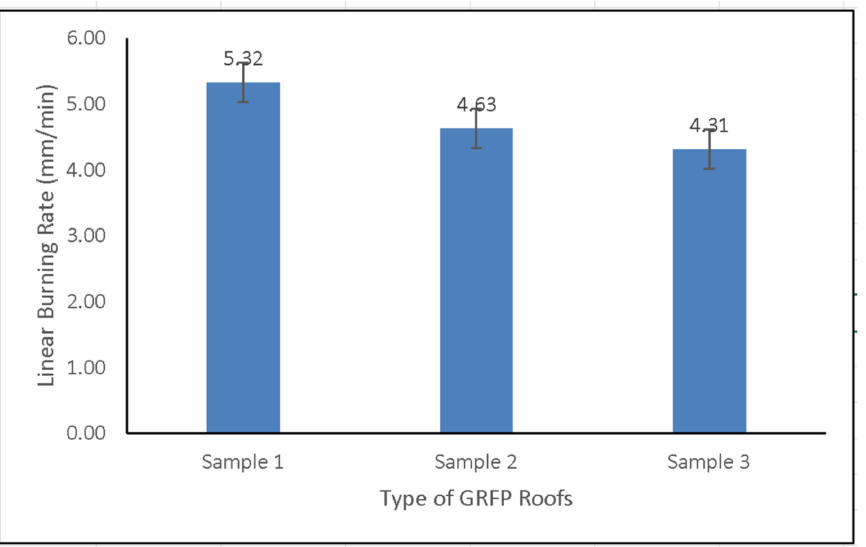
Figure 9. Linear burning rate of GFRP composite